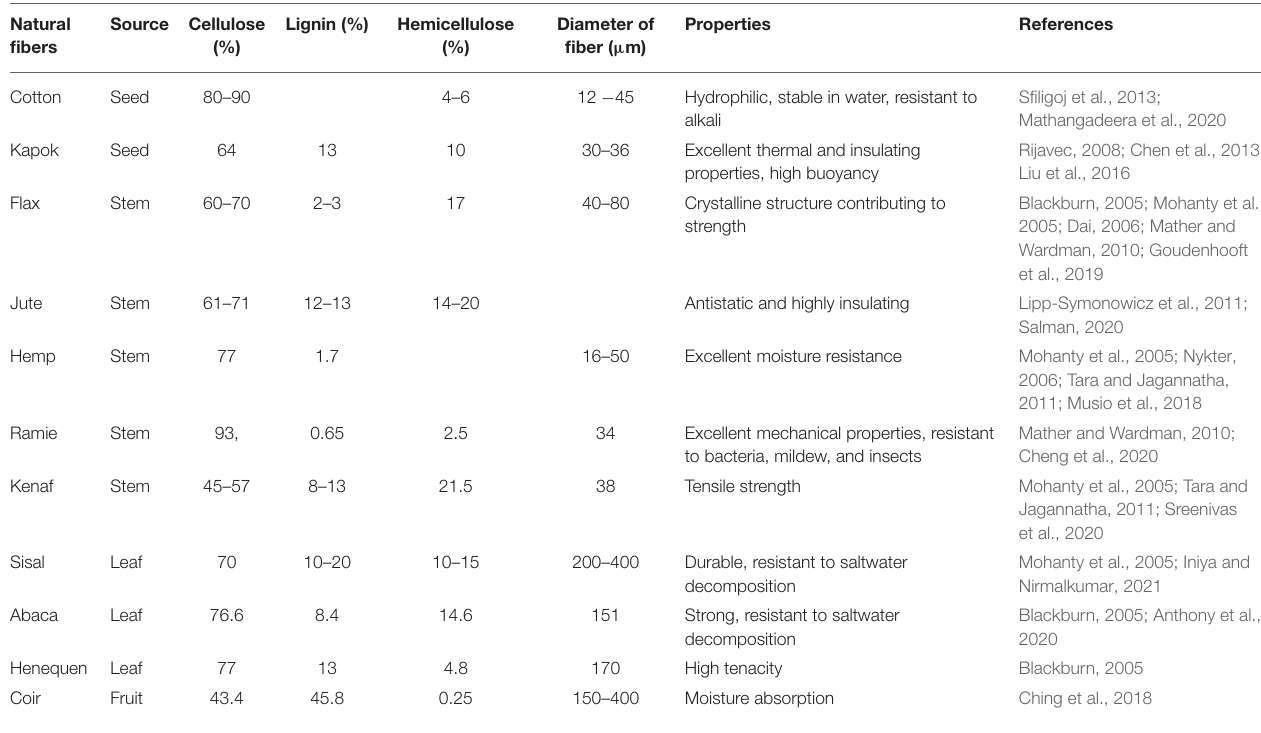
TABLE 2 | Composition and properties of conventional